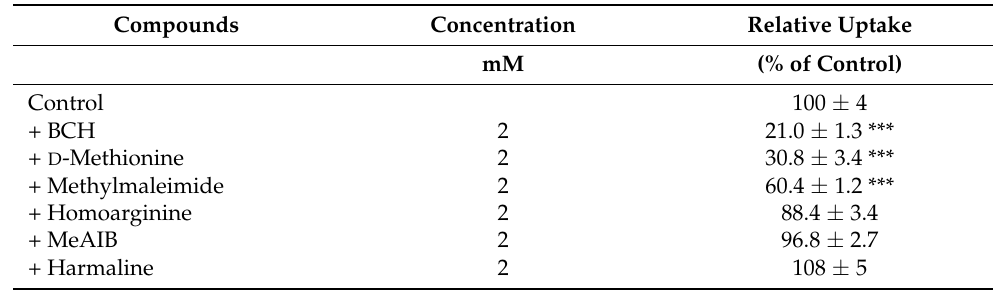
Table 2. Effect of transporter inhibitor on [ 3 H] L -tryptophan uptake by tryptophan in brain capillary endothelial (TR-BBB) cell